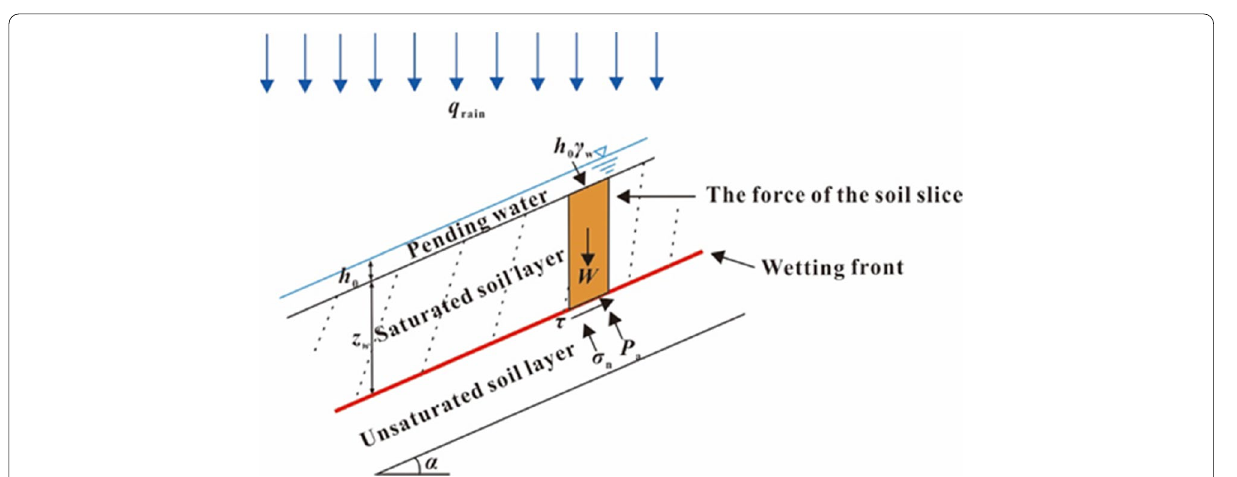
Fig. 6 Schematic diagram of the infinite slope